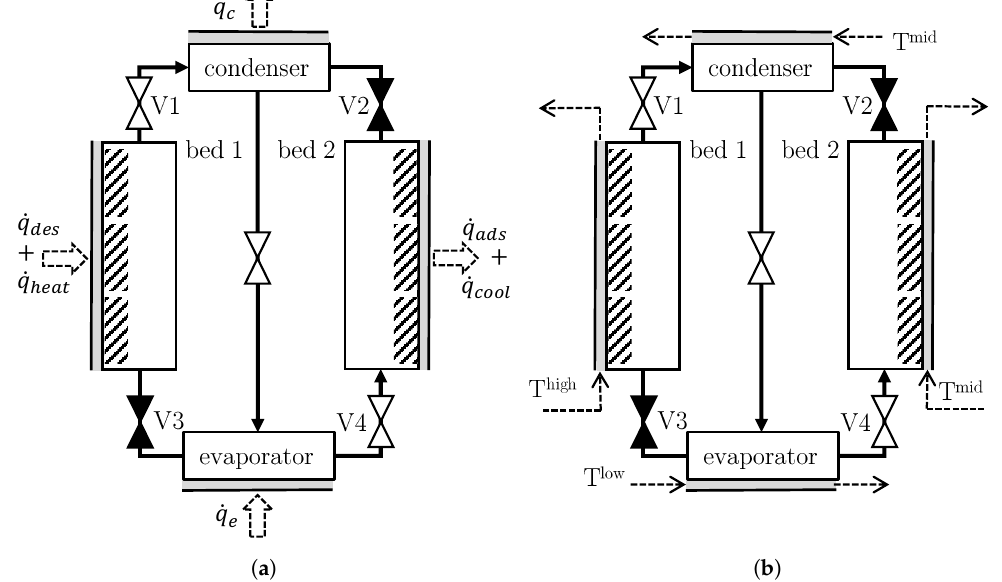
Figure 1. Two bed adsorption refrigeration process with external heat fluxes. Bed 1 in desorption and bed 2 in adsorption. ( a ) External heat inputs and outputs. ( b ) Temperature